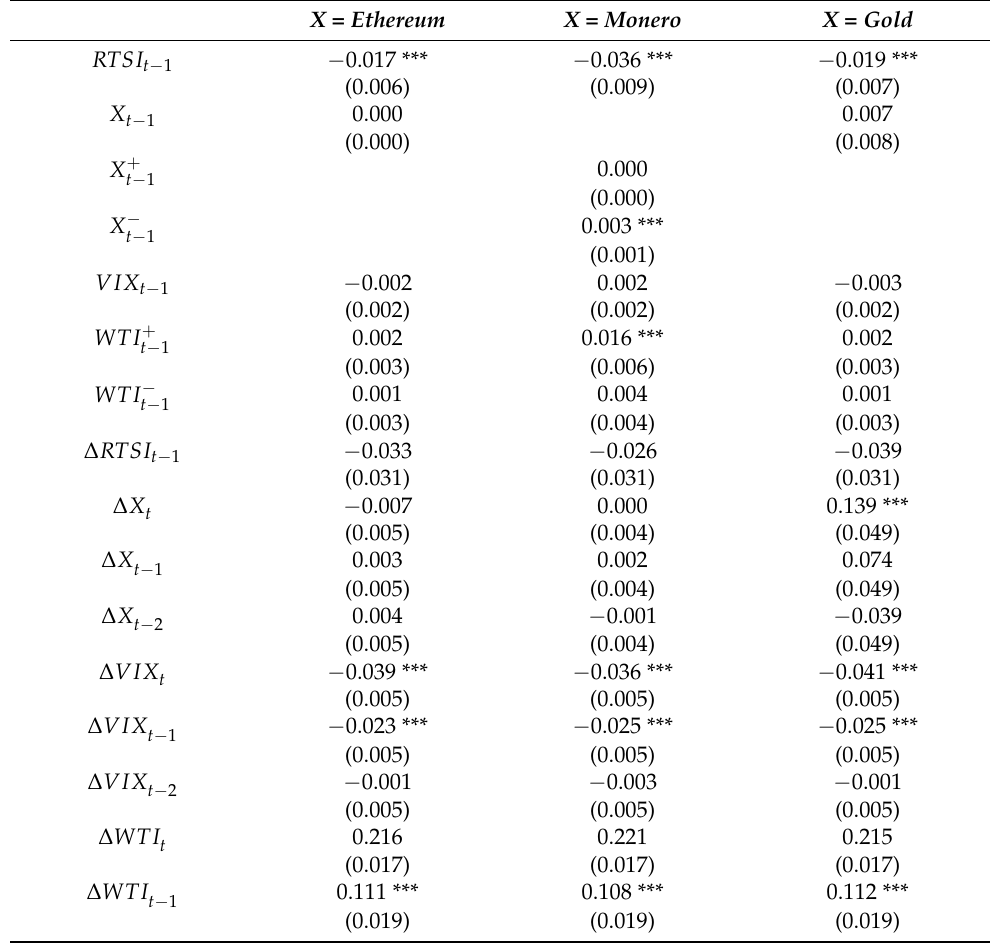
Table 9. Estimation results for RTSI before COVID-19.